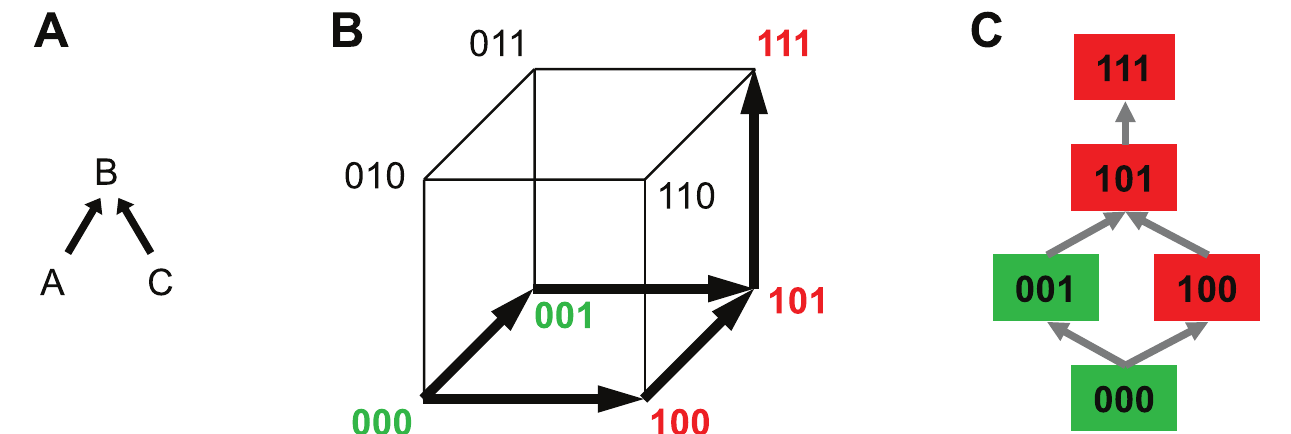
Figure 1. Schematic illustration of I-CBN model and individualized genetic barrier (IGB). (A) A partially ordered set of three mutations, A , B , and C , is considered with the two relations A [ B and C [ B , resulting in two possible escape pathways of the virus, namely A ? C ? B or C ? A ? B . (B) The partial order constraints give rise to the genotype lattice consisting of genotypes 000, 001, 100, 101, and 111 indicated with bold arrows, where genotypes are encoded as binary strings such that 000 is the wild type 1 (no mutations), 100 is defined by mutation A and identified with f A g , 101 with f A , C g , etc. The genotype lattice G is shown inside the embedding hypercube f 0,1 g 3 ^ 2 f A , B , C g . For each antiretroviral drug, genotypes are labeled as either susceptible (green) or resistant (red). (C) Genotype lattice isolated from the embedding hypercube. The IGB is the probability of the virus not reaching a resistant state.